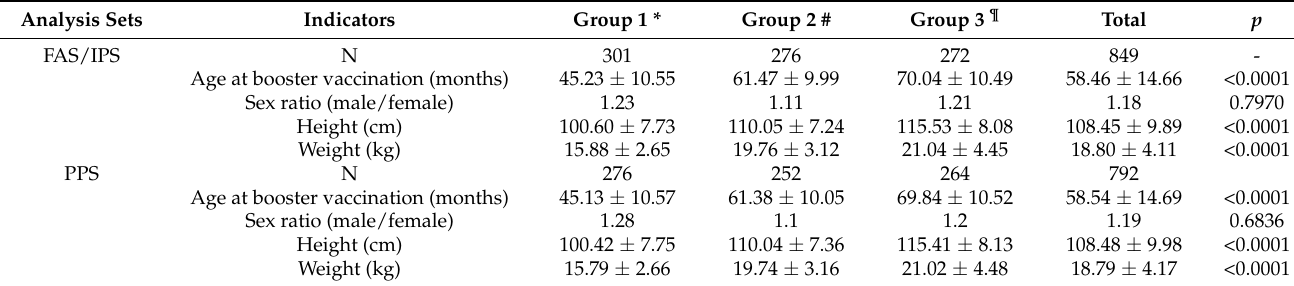
Table 1. Demographic characteristics of subjects in different groups.